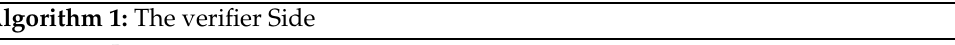
Algorithm 1: The verifier